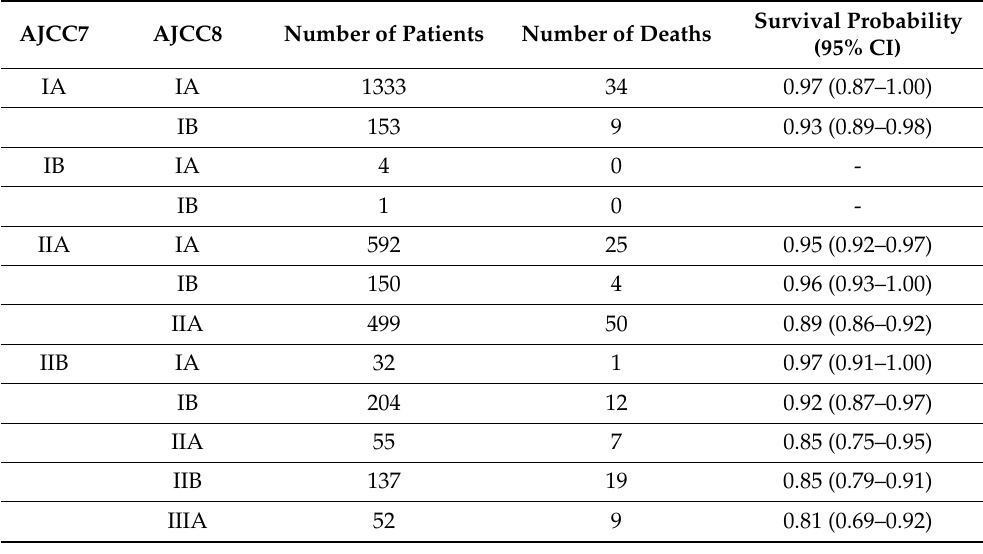
Figure 2. Stage distribution of AJCC7 and AJCC8 (AJCC7 in blue, AJCC8 in orange). Median follow-up time was 67 months (IQR: 39 – 100). The five-year overall survival rate varied between 97% (95% CI: 95% – 98%) for stage IA and 66% (95% CI: 60% – 73%) for stage IIIC for AJCC7, and 96% (95% CI: 95% – 97%) for stage IA and 60% (95% CI: 51% – 70%) for stage IIIC for AJCC8 (Figures 3 and 4, Table S2). Women who were downstaged had a higher five-year overall survival rate than was predicted based on their original stage. For example, women who would have been classified as having stage IIIA breast cancer under the AJCC7 system were reclassified to stage IB under the new AJCC8 staging system. The corresponding five-year survival rate in the 150 patients who experienced this phenomenon was 95%, higher than the 88% that would have been expected for stage IIIA under AJCC7. Conversely, upstaged patients had a generally worse five-year overall survival than was predicted based on their original stage (Table 3, Figure S1). Table 3. Five-year overall survival rate among upstaged, downstaged and unchanged patients (AJCC7 to AJCC8).